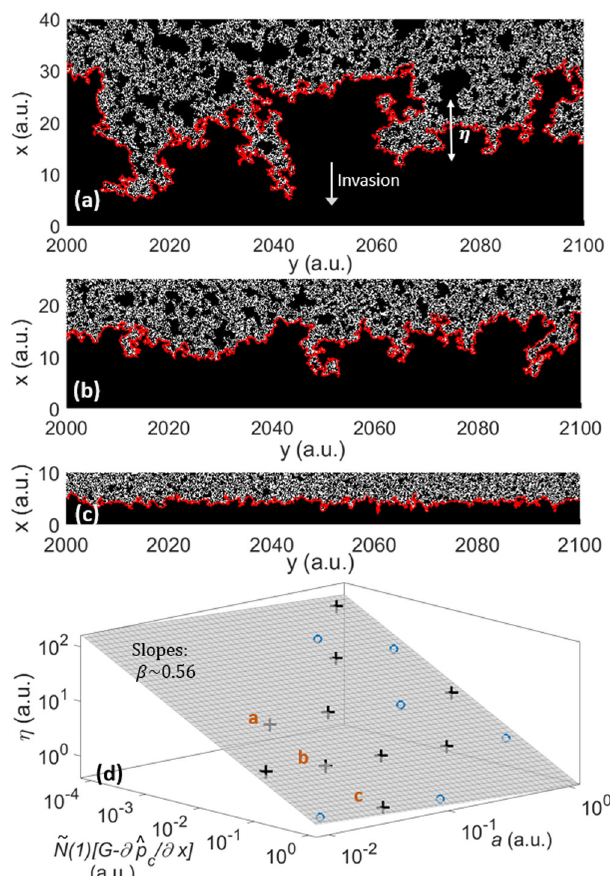
Fig. 4 Invasion percolation simulations — stabilising gradient. a to c : invasion percolation maps for the three simulations denoted in d , that have different stabilising gradient in invasion threshold. The invading non- wetting phase occupies the white pixels. The plain (red) line is the drainage front on which the width η is computed. Length are in an arbitrary unit, denoted a.u. d : Width of the front as a function of the pore size a , of the = ∂ x , of the external fi eld G and of the local distribution in gradient ∂ ^ p c capillary pressure ~ N (logarithmic scales). Each data point was computed on an independent simulation. Crosses represent simulations with only a structural gradient in pore threshold ( G = 0), whereas circles mark simulations also including an external fi eld ( G varying from − 10 − 4 to + 10 0 a.u. depending on the simulation). The grey plane is a fi t of Eq. (12). The slopes of this plane along the two axes are given by − β and by 1 − 2 β , respectively, and both indicate β = 0.56 ±